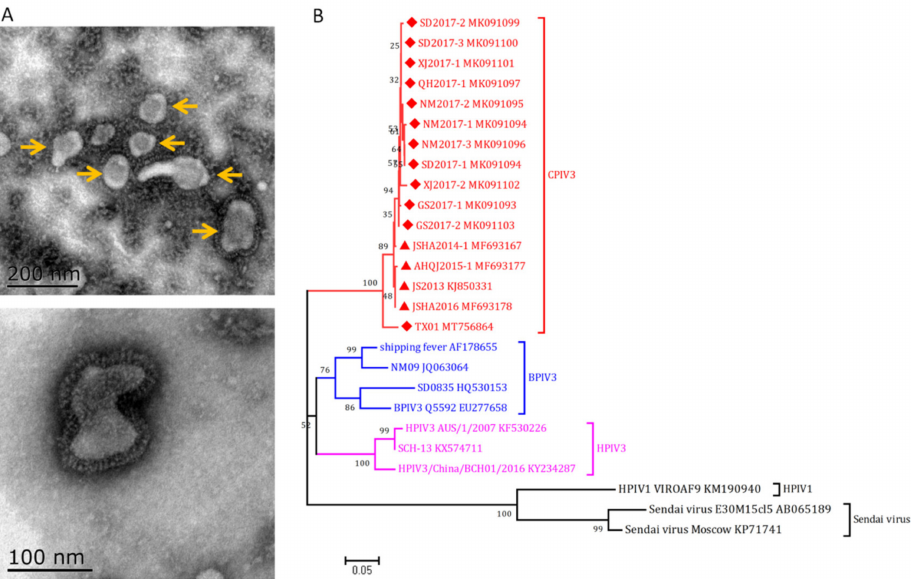
Figure 1. Morphology and phylogenetic analysis of CPIV3. ( A ) Morphology observation of CPIV3 under electron microscope. Two hundred milliliters of virus stock was centrifuged at 8000 × g for 0.5 h to remove the cell debris; the supernatant was then ultracentrifuged at 100,000 × g for 2 h. The resulting pellet was dissolved in 1mL PBS and stained with phosphotungstic acid (PTA), blotted dry, and examined with an electron microscope (H-7650, HITACHI). Spherical to pleomorphic virions with a diameter of 100–200 nm were observed. ( B ) Phylogenetic analysis of the reported CPIV3 strains and reference respiratory strains based on M gene sequences using MEGA 7 software. The red triangle and rhombus indicate the goat and sheep originated strains,